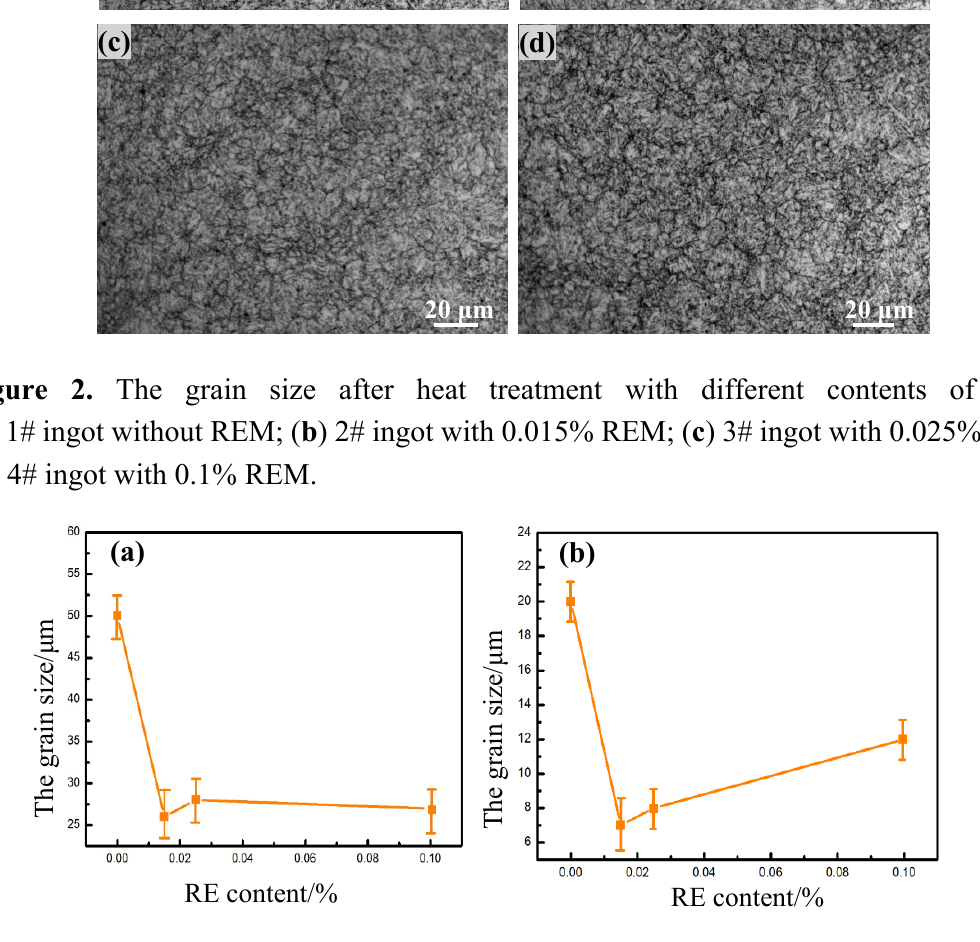
Figure 3. The grain refinement for the casted state ( a ) and after heat treatment; ( b ) tested by image statistic